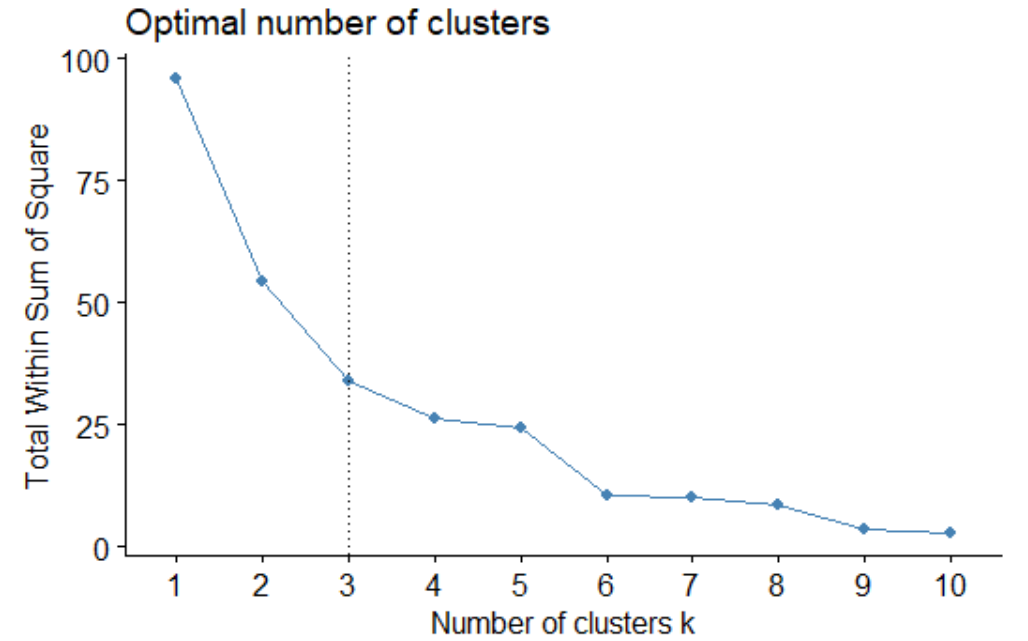
Figure 10. Determination of the optimal number of the cluster for vegetative cover vulnerability analysis (the optimal cluster number is 3, as it appears to be the bend in the knee/elbow).